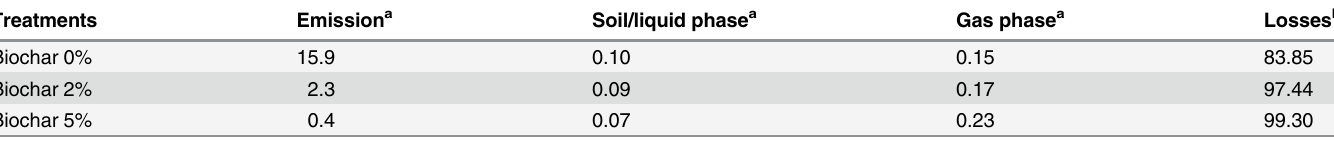
Table 2. Fate of CP after application to soil columns.